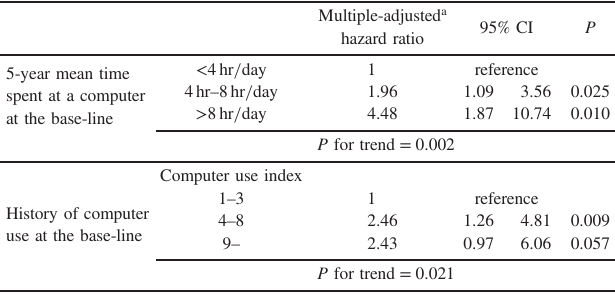
Table 3. Adjusted hazard ratios and 95% con fi dence intervals for the association of computer use with the FDT-VFA among subjects with refractive errors